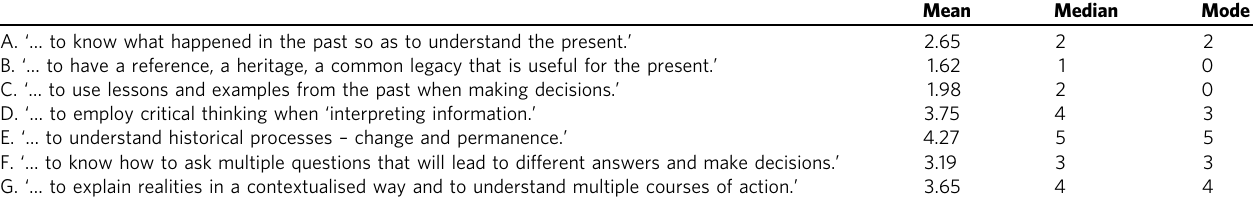
Table 6 Descriptive statistical measurements summary regarding question 3 about what ‘ Thinking historically ’ may mean.